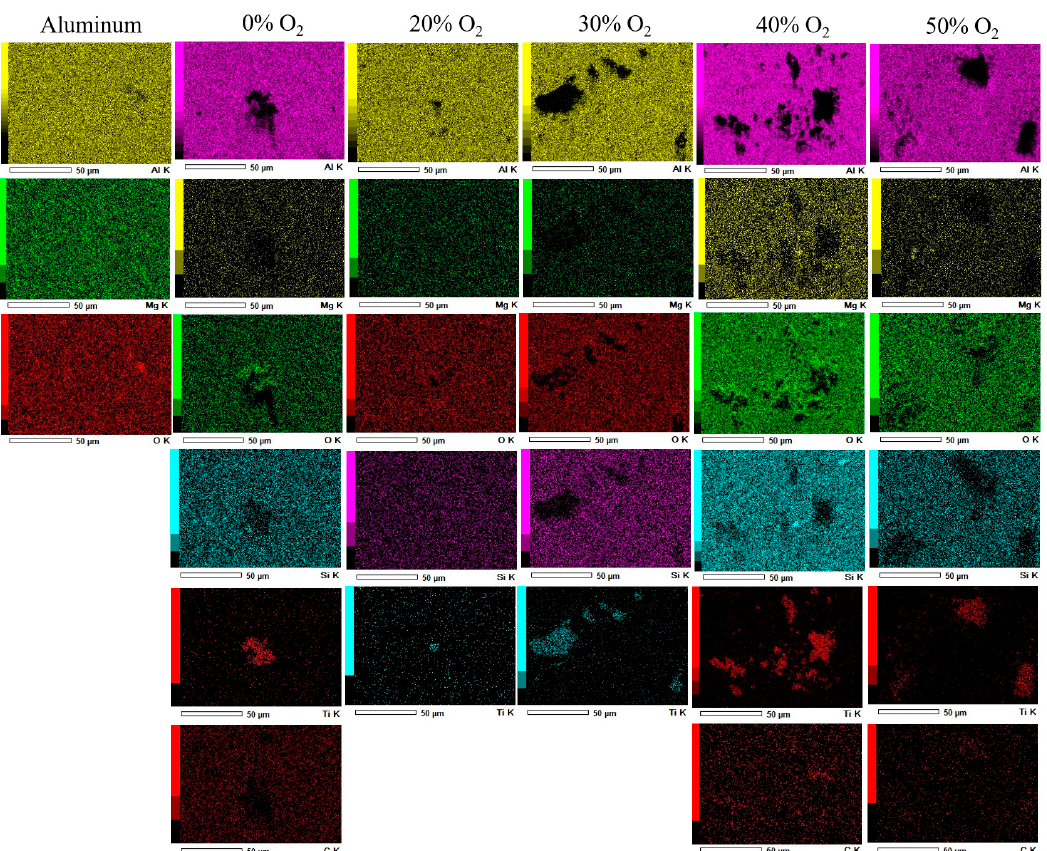
Figure 8. Compositional maps of samples prepared in plasmas containing different proportions of O